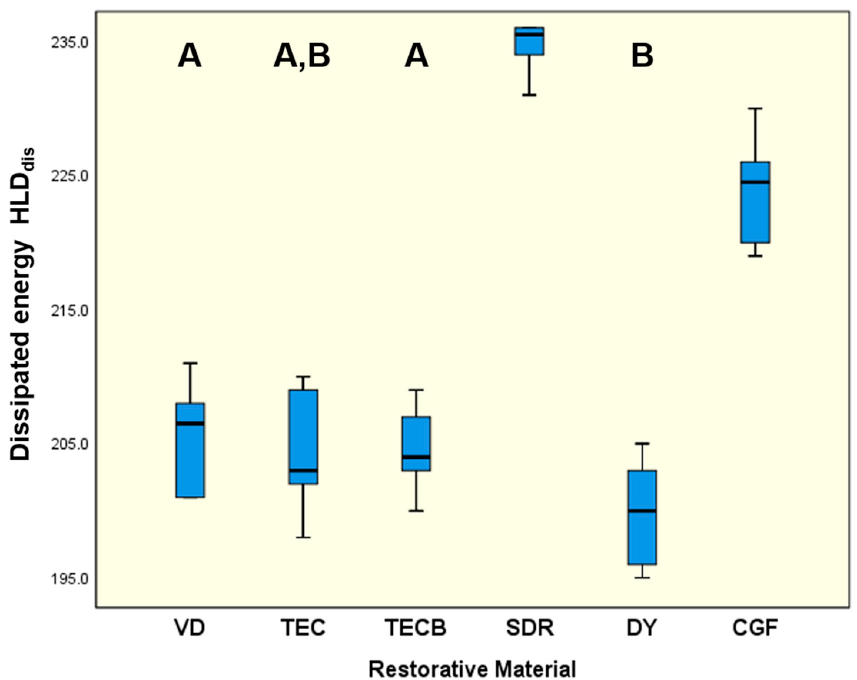
Figure 6. Dissipated energy during Leeb hardness testing (HLD dis ). Identical uppercase letters denote no significant difference among groups ( p > 0.05), while different uppercase letters represent significant differences ( p < 0.05). HLD dis represents a dimensionless property.